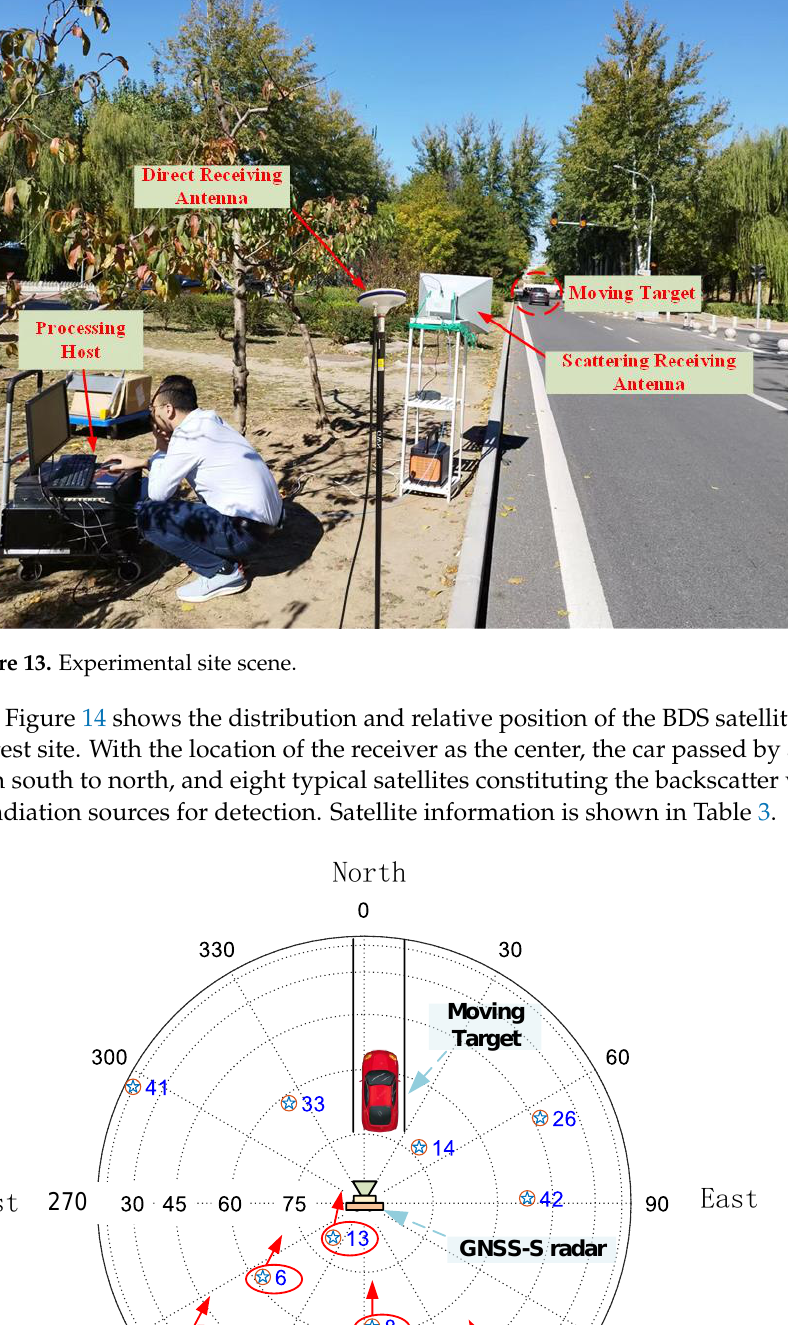
13 of 21 Figure 12. Signal Accumulation Result after Amplitude Correction. 4.2. Field Experimentation In order to further prove the effectiveness of the proposed method, field experi- mentation was carried out in Beijing Environmental Science and Technology Park using the experimental equipment shown in Figure 1, and the BDS satellite B3 frequency band